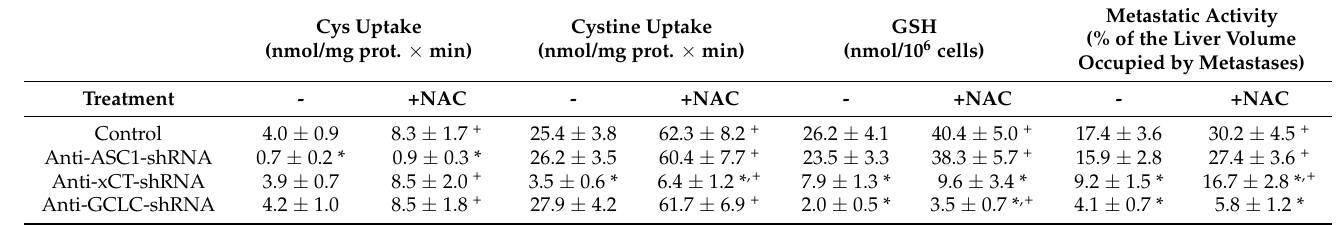
Table 2. Effect of inhibition of Cys/cystine uptake or GSH synthesis on GSH levels and metastatic activity in B16-F10 cells. Cancer cells were transfected in vitro, as explained under Material and Methods, before their in vivo inoculation. B16-F10 cells were inoculated i.v. (portal vein). NAC (240 mg/kg) was administered orally for 10 days, starting 120 min after B16-F10 cells inoculation. All measurements were performed in the liver or in metastatic cells isolated from the liver 10 days after tumor inoculation. Results obtained using melanoma cells treated with scrambled RNA sequences were not significantly different from those displayed as non-treated controls. * Significantly different p < 0.01, comparing shRNA-treated cells versus controls; + Significantly different p < 0.01, comparing NAC-treated mice versus mice treated with vehicle (n =